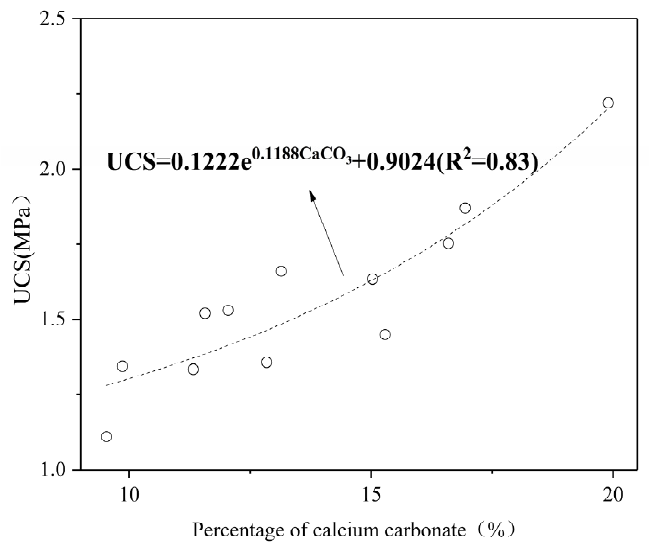
Figure 13. Relationship between the content of calcium carbonate and unconfined compressive strength.